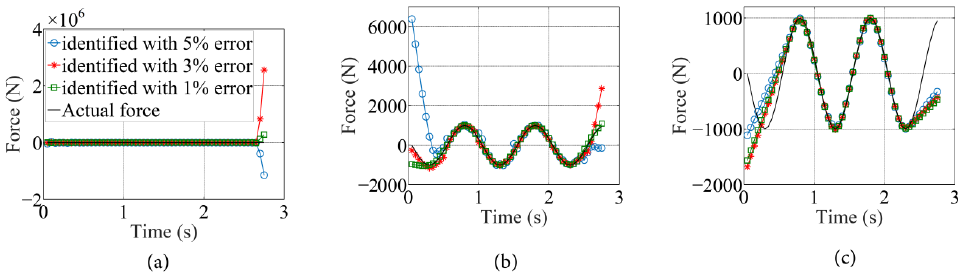
Figure 7. The identified sinusoidal load with four sensors and ( a ) no regularization, ( b ) γ = 10 − 22 , and ( c ) γ = 10 − 18 .